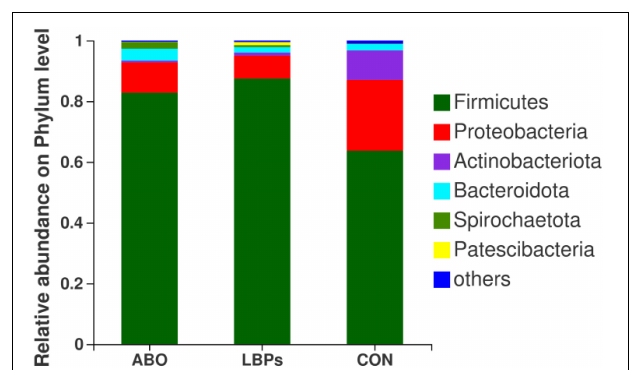
FIGURE 2 | Phylum-level relative abundance of 16S rRNA gene sequences from the cecal digesta of weaned piglets ( n = 8). CON, basal diet; LBPs,